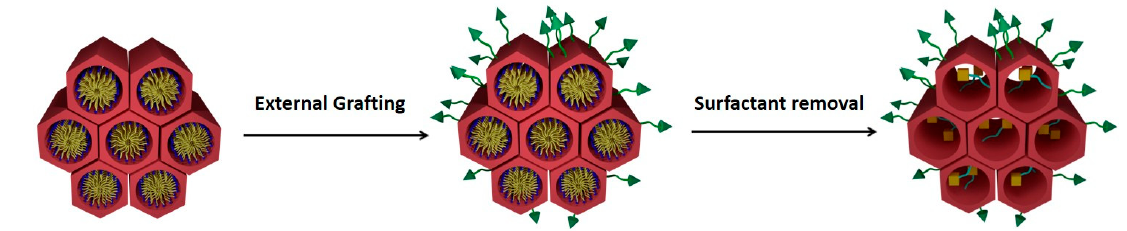
Figure 2. Regioselective di-functionalization of Figure 2 . Regioselective di-functionalization of MCM-41.